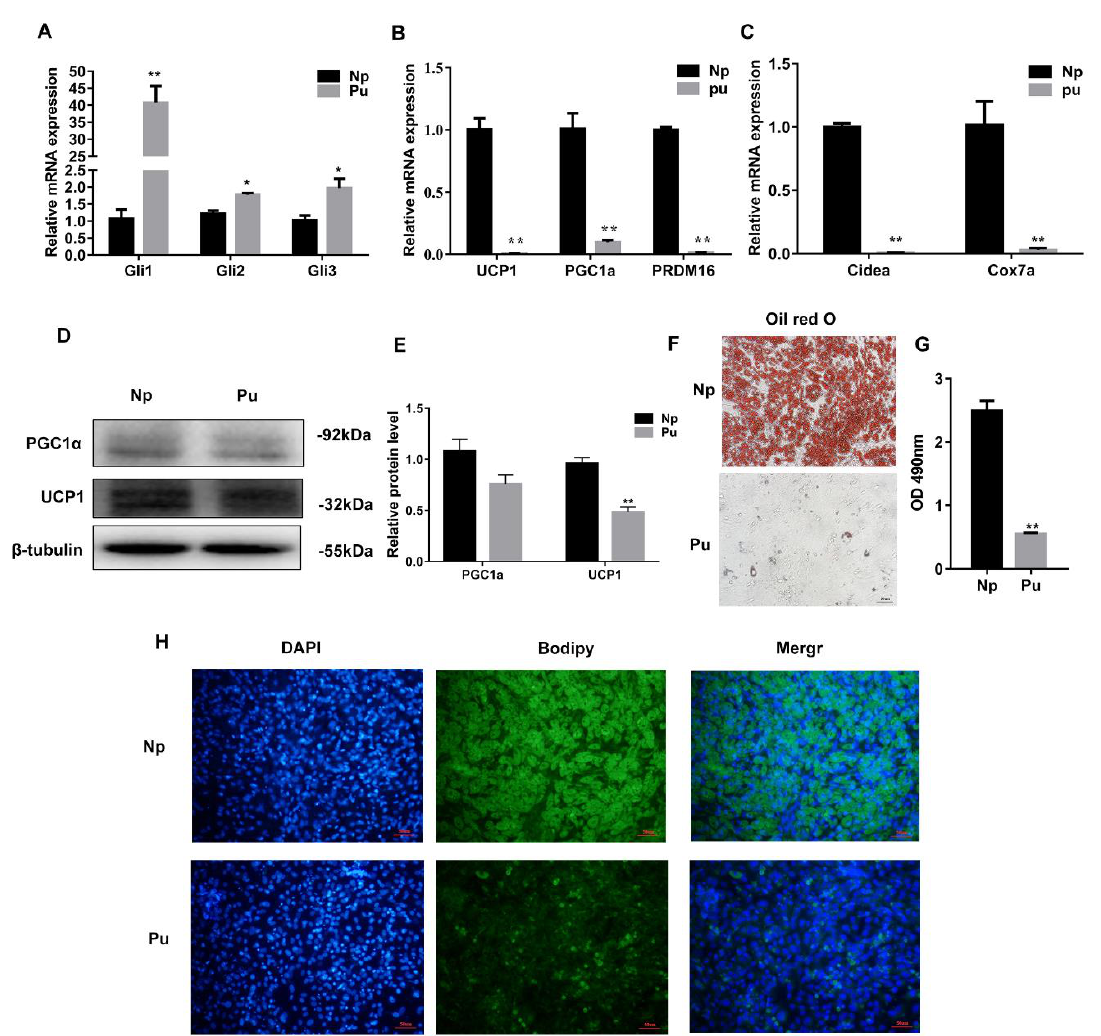
Figure 4. Hh signaling pathway activation inhibited white adipocyte browning. ( A – C ) RT-qPCR analysis of the gene expression of the Hh signaling pathway key transcription factor Glis, white adipose thermogenesis related gene expression, and expression of mitochondrial related genes. ( D ) Western blotting to detect the genes associated with white adipose thermogenesis expression. ( E ) The resulting quantity protein level. ( F ) Oil red O staining. ( G ) The result of oil red O extraction. ( H ) Bodipy staining. Scale bar = 10 µm *, p < 0.05; **, p < 0.01. (Note: Np is the purmorphamine (Pu) control, Pu was dissolved in DMSO).